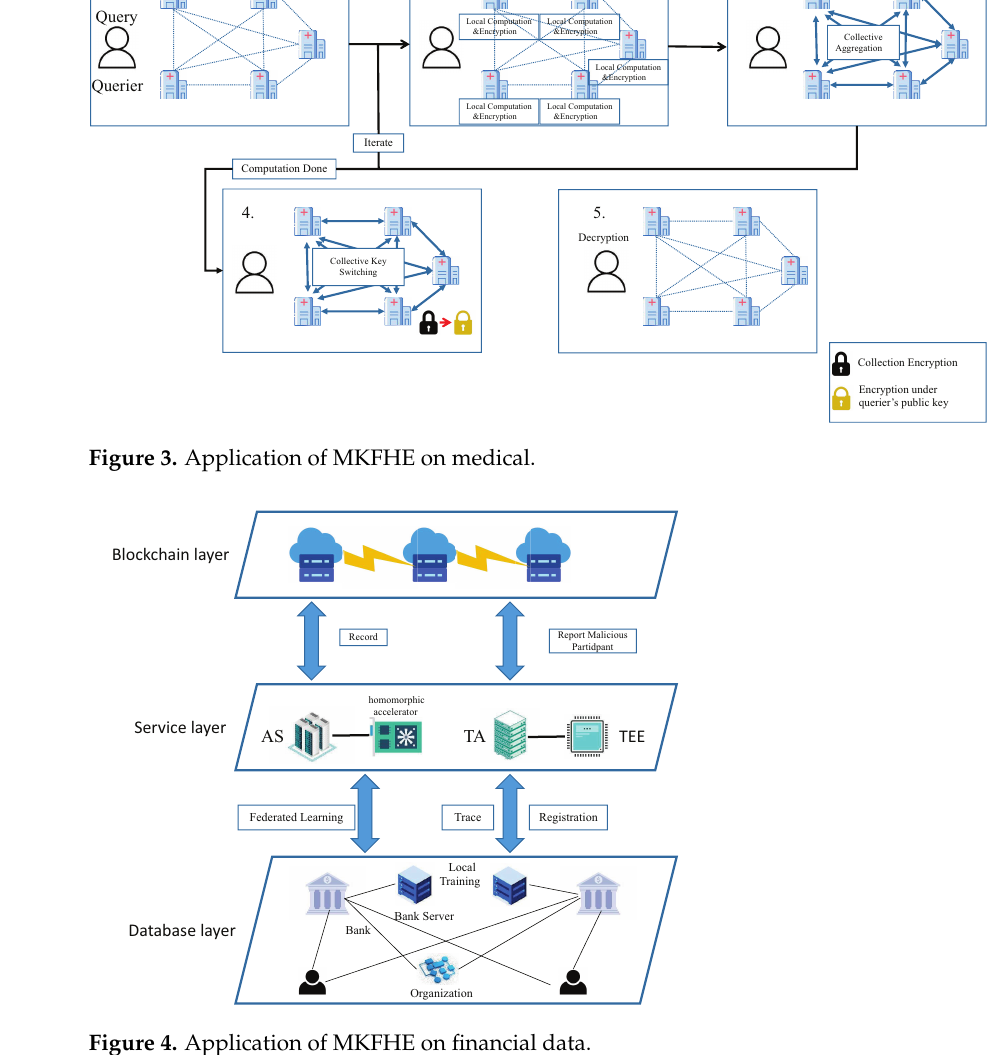
Figure 4. Application of MKFHE on financial